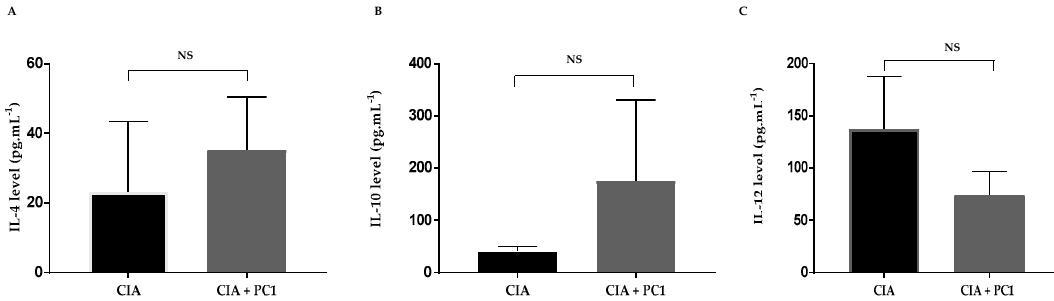
Figure 4. Levels of cytokines IL-4 ( A ), IL-10 ( B ) and IL-12 ( C ) after L. fermentum PC1 administration in collagen induced arthritis (CIA) mice. CIA mice were orally administered PBS daily from Day 2 until end of experiment. CIA + PC1 received viable L. fermentum PC1 (1 × 10 9 CFU) daily. Control were healthy age matched mice. Serum levels of cytokines IL4, IL-10 and IL-12 were measured by ELISA. Results are shown as the mean ± SEM of 12 mice per group. NS denotes non-significance between the groups tested.